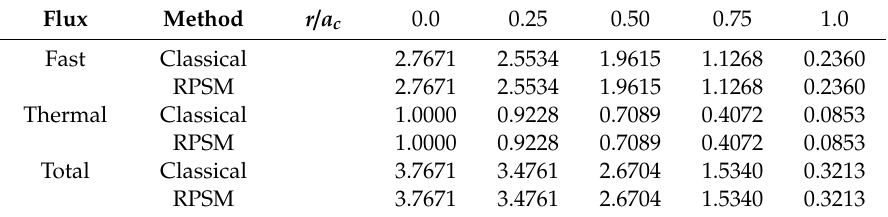
Table 7. The slab reactor critical radius for two boundary conditions.